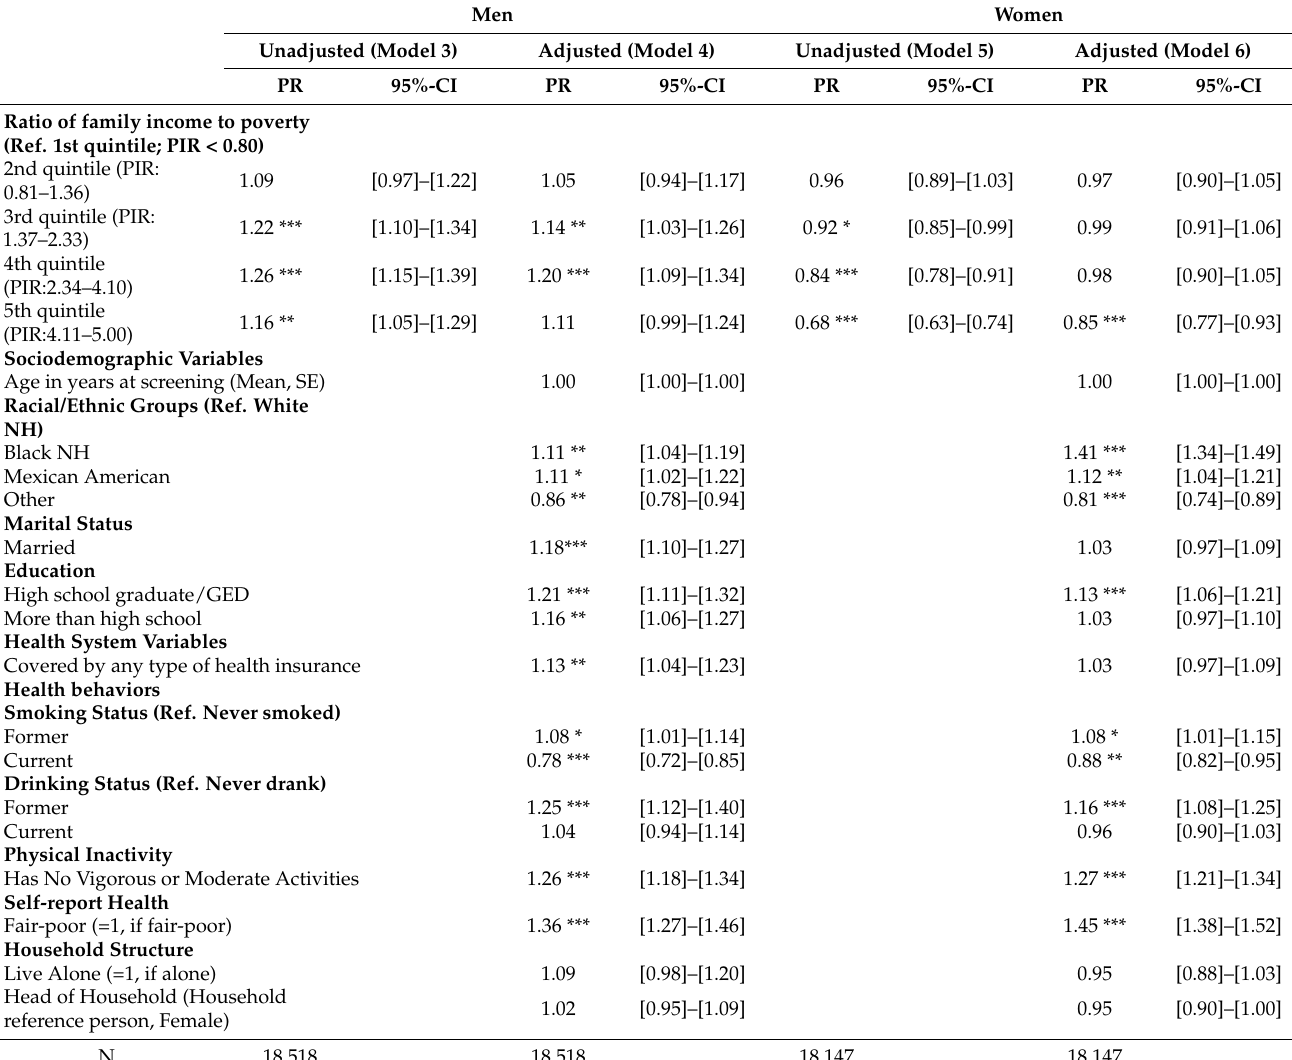
Table 3. Association between income differences and obesity in US Adults in the 1999–2016 National Health and Nutrition Examination Survey. Men Women Unadjusted (Model 3) Adjusted (Model 4) Unadjusted (Model 5) Adjusted (Model 6) PR 95%-CI PR 95%-CI PR